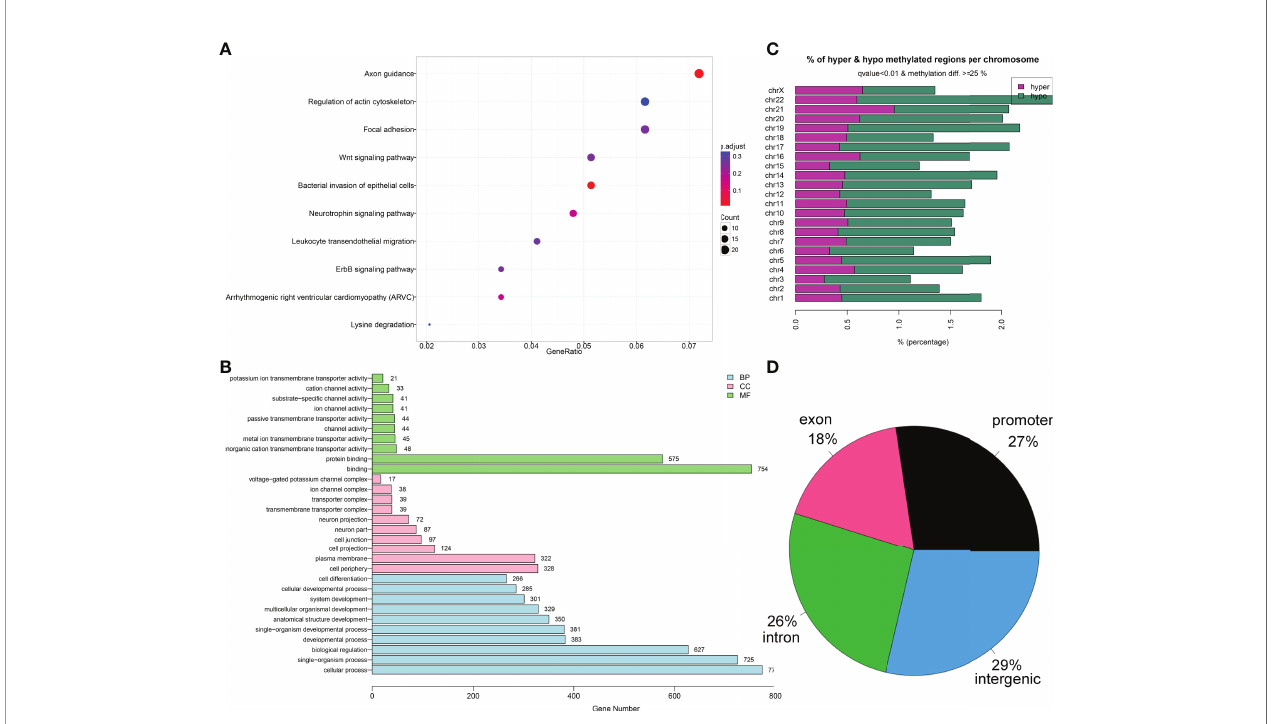
FIGURE 2 | Bioinformatics analysis of the differentially methylated fragments/genes in MDS. (A) Kyoto Encyclopedia of Genes and Genomes analysis of 1,459 differentially methylated fragments/genes between MDS patients and controls. (B) Gene Ontology analysis of 1,459 differentially methylated fragments/genes between MDS patients and controls. (C, D) The locations of 1,459 differentially methylated fragments in the distribution of chromosome and gene